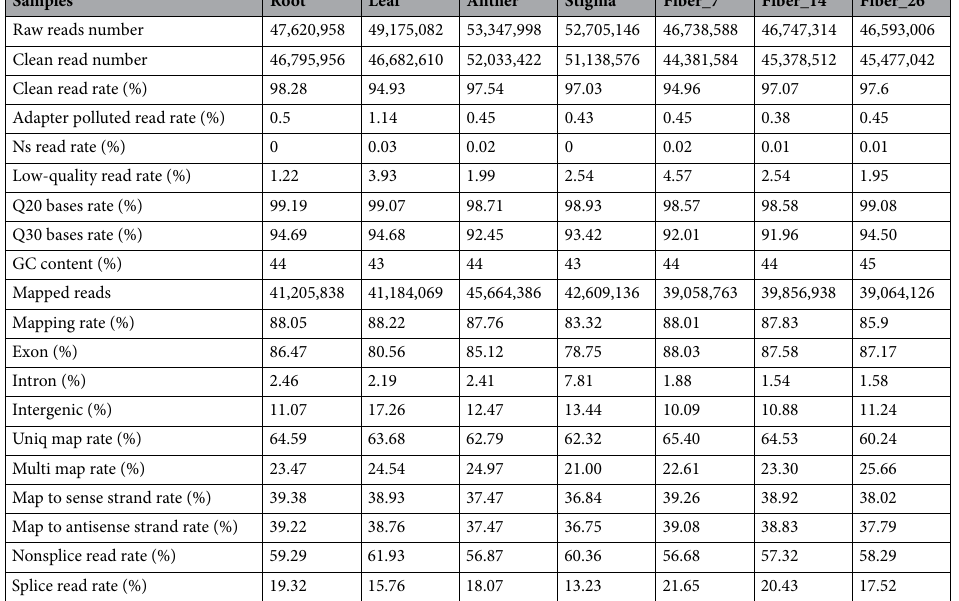
Table 1. Statistical table of transcriptome sequencing